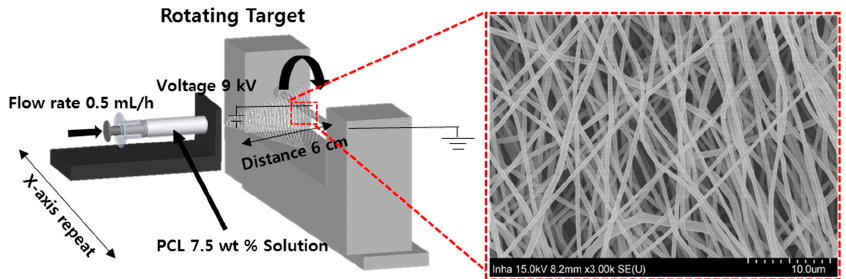
Figure 2. Schematic of electrospinning process.